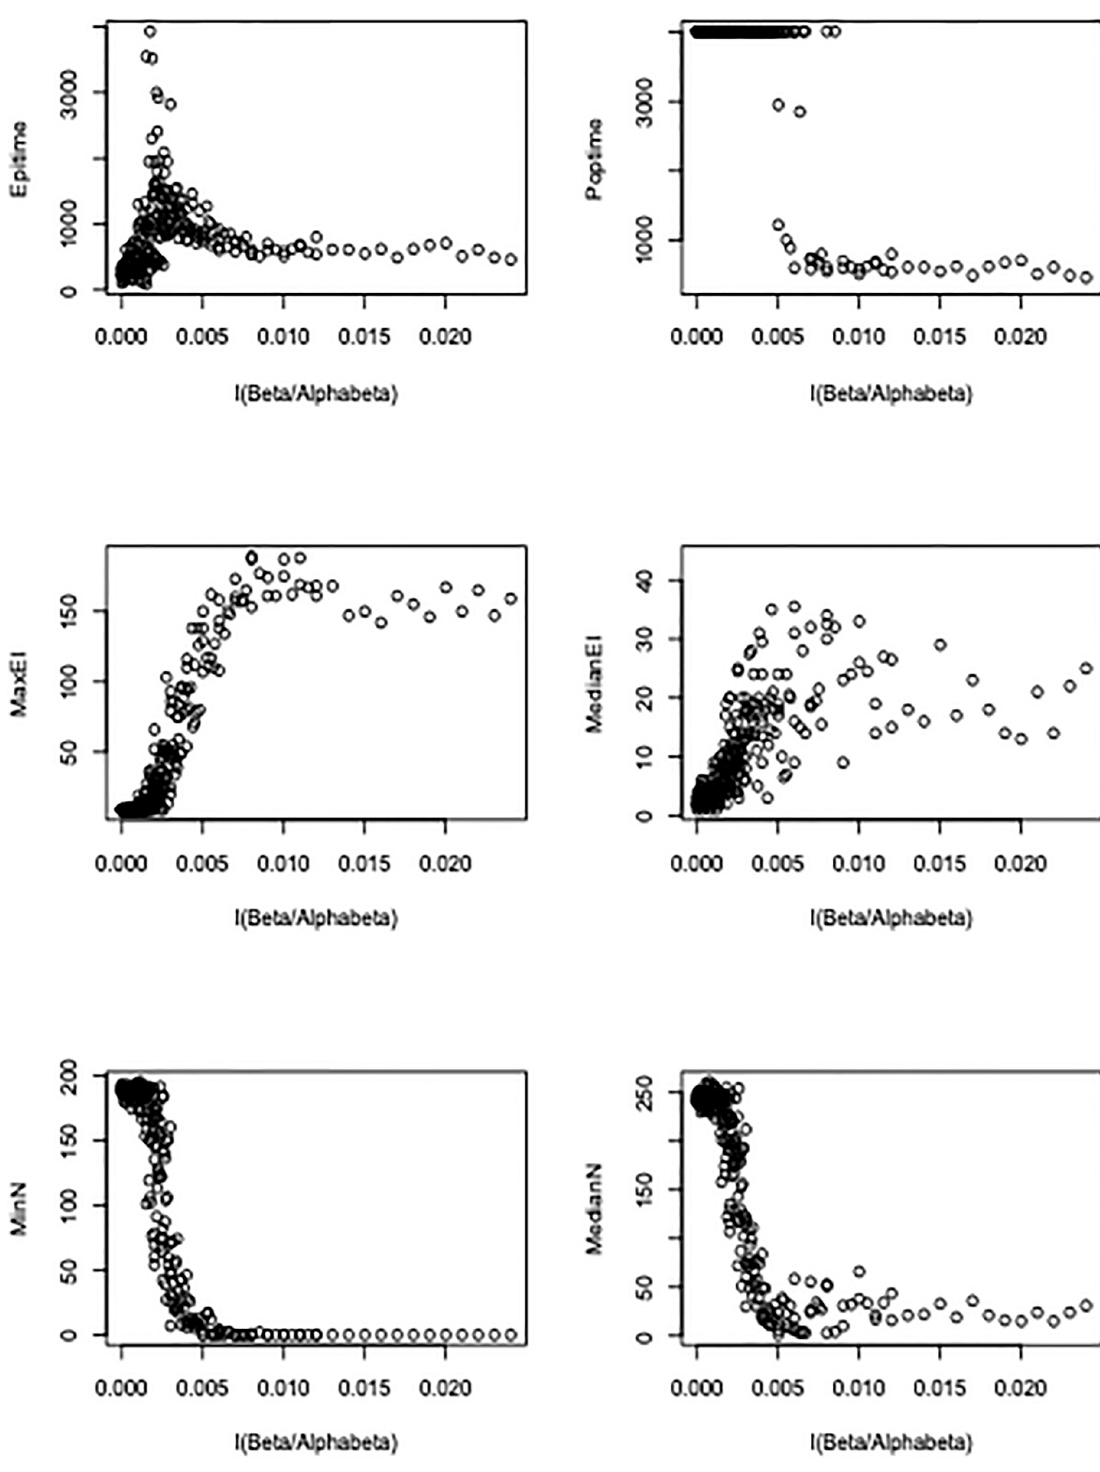
Fig 4. The effect of disease projection ( β / α β ) on metaseir-simulated epidemic times (Epitime), kit fox population persistence time (Poptime), number of infected individuals (MaxEI, MedianEI), and kit fox population size (MinN, MedianN). Data points were generated by the call: > h = 49; beta49.3noEIbirth = autometabeta(trials = 1, betav = seq(0.0000,0.0024,0.0001), alphabetav = seq(0,1,0.1)). This runs metaseir 275 times, covering a variety of beta and alphabeta values.